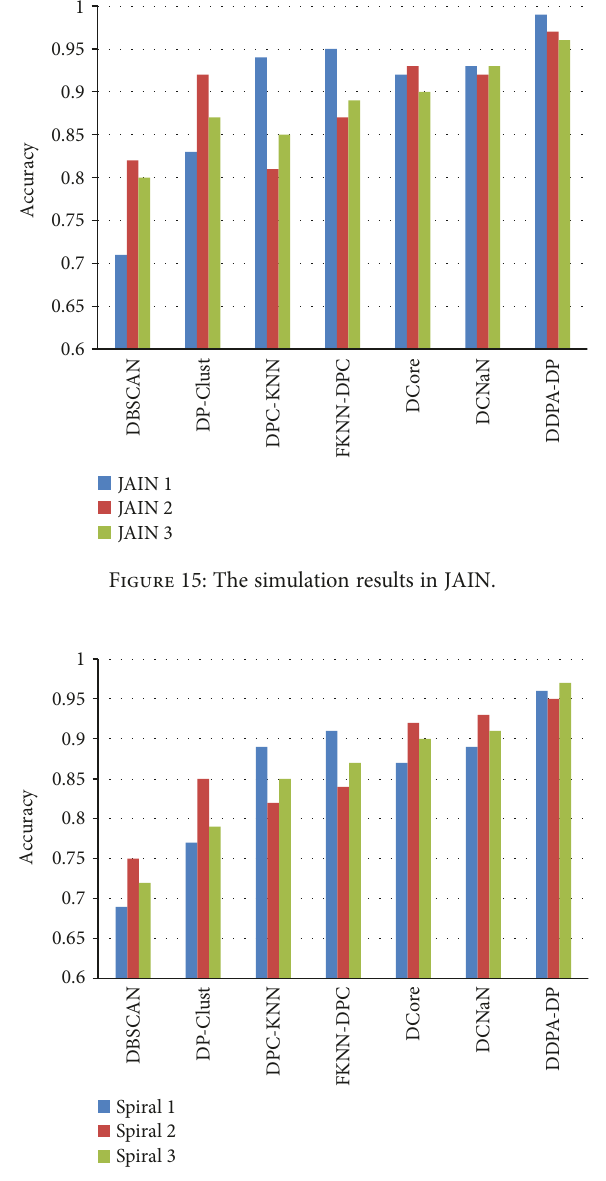
Figure 16: The simulation results in Spiral.